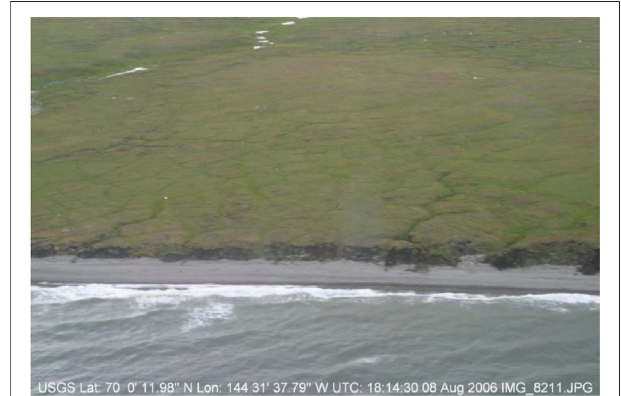
FIGURE 9 | Example photo of coastal bluffs where bluff face thaw/ slumping was the predominant erosion mechanism (image courtesy of Ann Gibbs, U.S. Geological